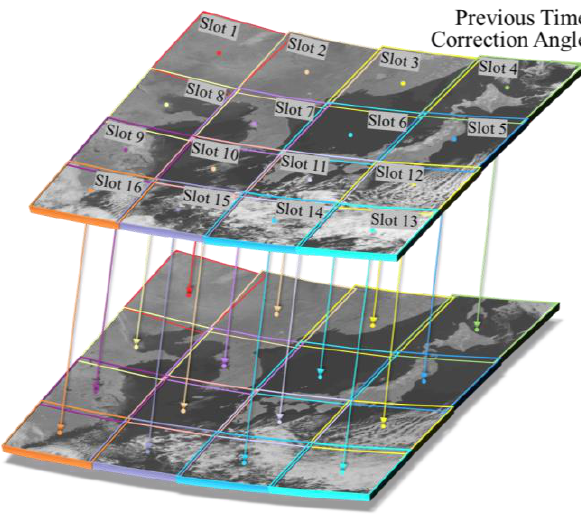
Figure 2. Using previous time correction angle 2.1.2